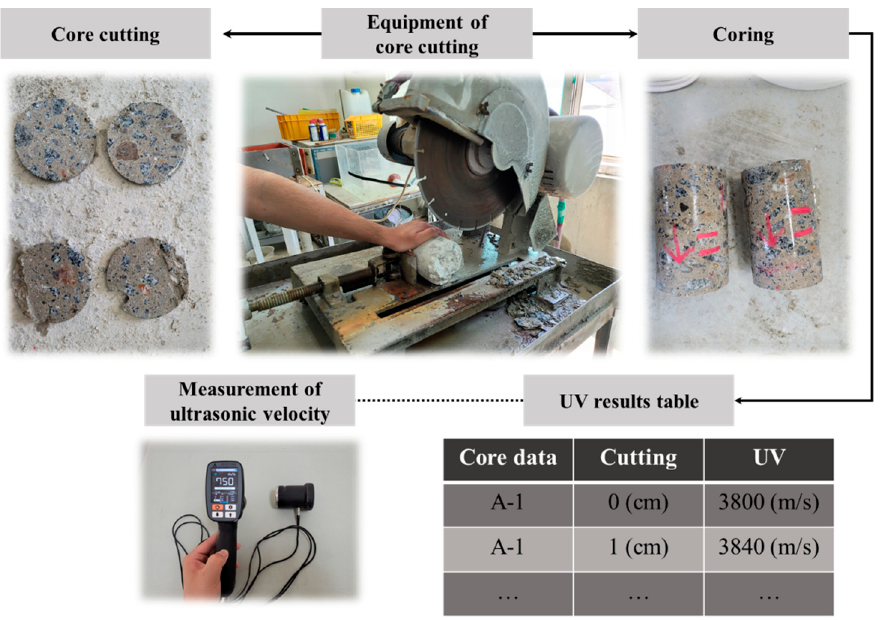
Figure 4. Repeated ultrasonic velocity test method for deterioration area removal.